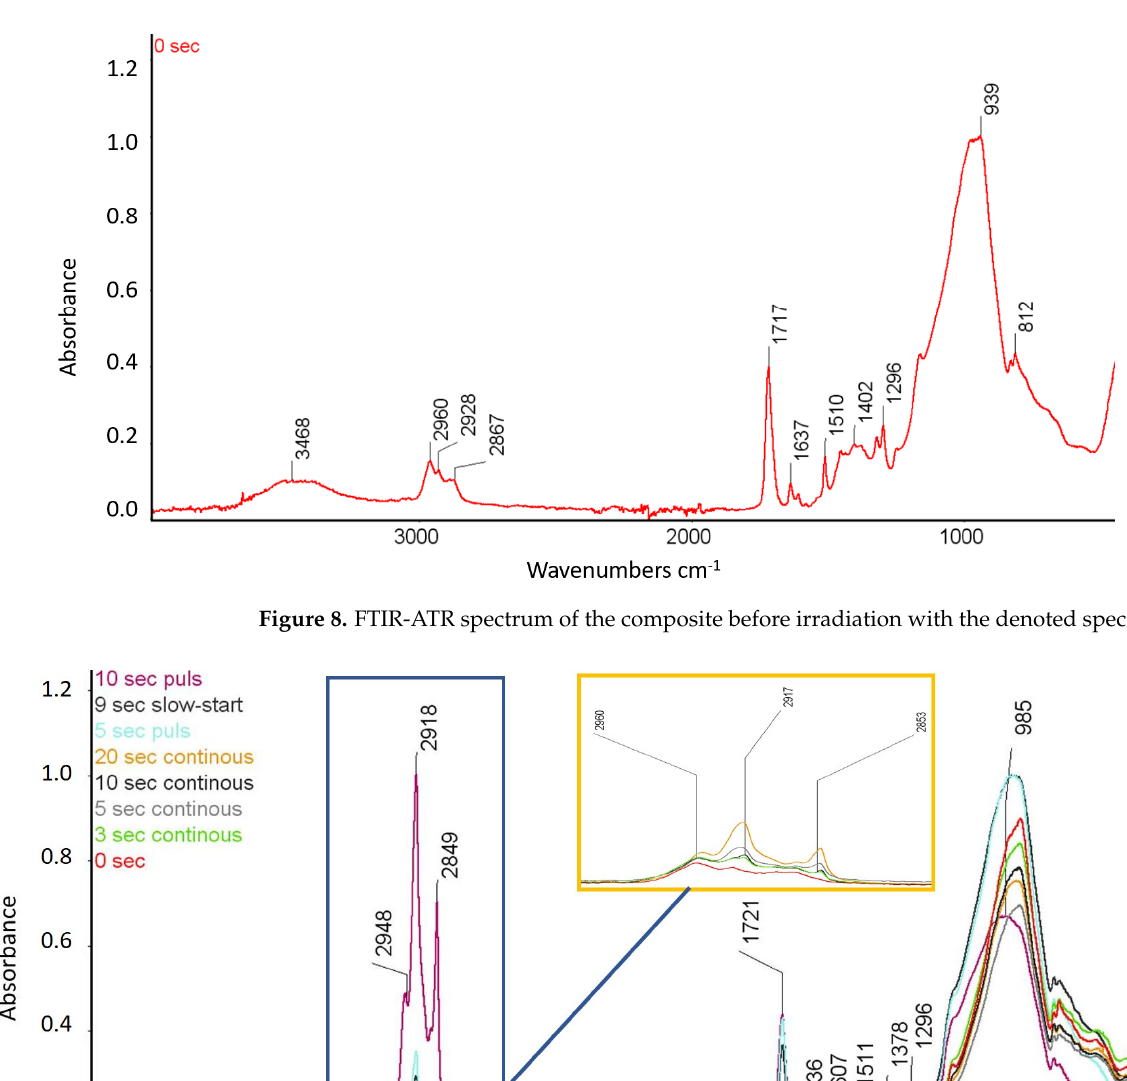
Figure 8. FTIR-ATR spectrum of the composite before irradiation with the denoted spectral bands.